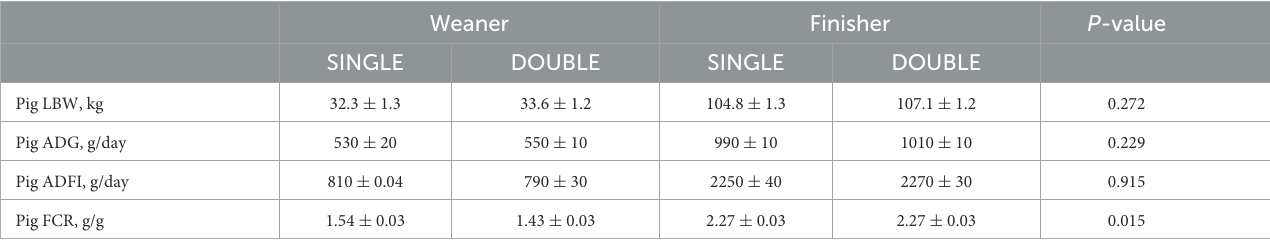
TABLE 5 Differences (LS means ± SE) between treatments on measures of animal performance from day 28 to 120, for a total of 12 pens per treatment (12 pigs/pen), with an original weight of 8.6 ± 1.49kg each pen.